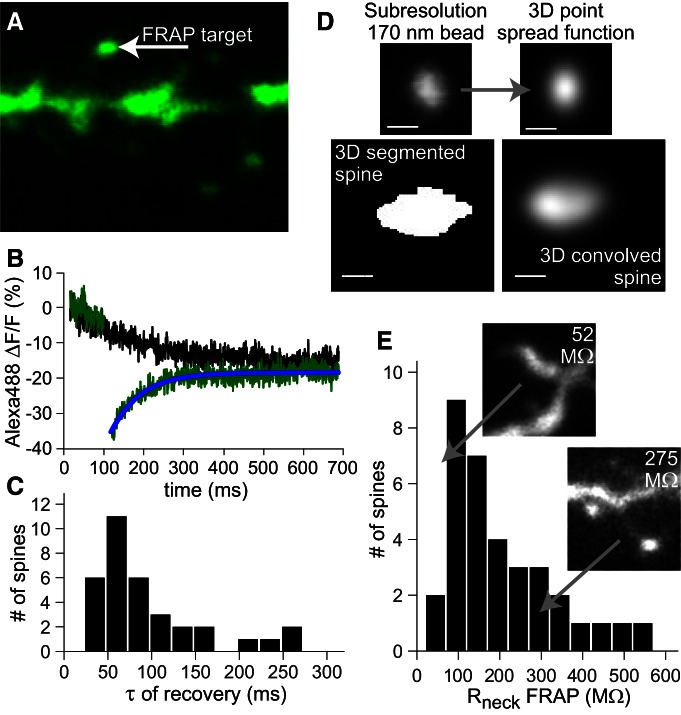
FRAP of an intracellular cytosolic dye was used to estimate Rneck. A, Sample image with spine targeted for photobleaching. Cells from the same population of neurons were filled with the cytosolic dye AlexaFluor 488. B, After a 0.5 ms pulse of 770 nm excitation light, photobleaching of green fluorescence was apparent. Recovery approached control (black trace) and was fit to a single exponential (blue curve). C, Histogram of fit exponential time constant (τ) values from N = 34 spines (mean = 95 ± 11 SE, median 72 ms). D, Conversion to Rneck depends on the spine head volume (Eq. 2). We estimated spine head volume by 3D segmentation of Z-stack spine images (770 nm excitation) into binary images, eroding or dilating these binary 3D images to produce a series of sizes and then convolving with the 3D point spread function of the microscope obtained using 170 nm fluorescent beads. The resultant set of blurred images were then correlated with the experimental image to obtain the best fit. The source binary image which produced the best fit was then used to determine the spine head volume. E, Histogram of Rneck values calculated from FRAP experiments (mean 204 ± 21 SE MΩ), with inset examples of large and small resistance examples.